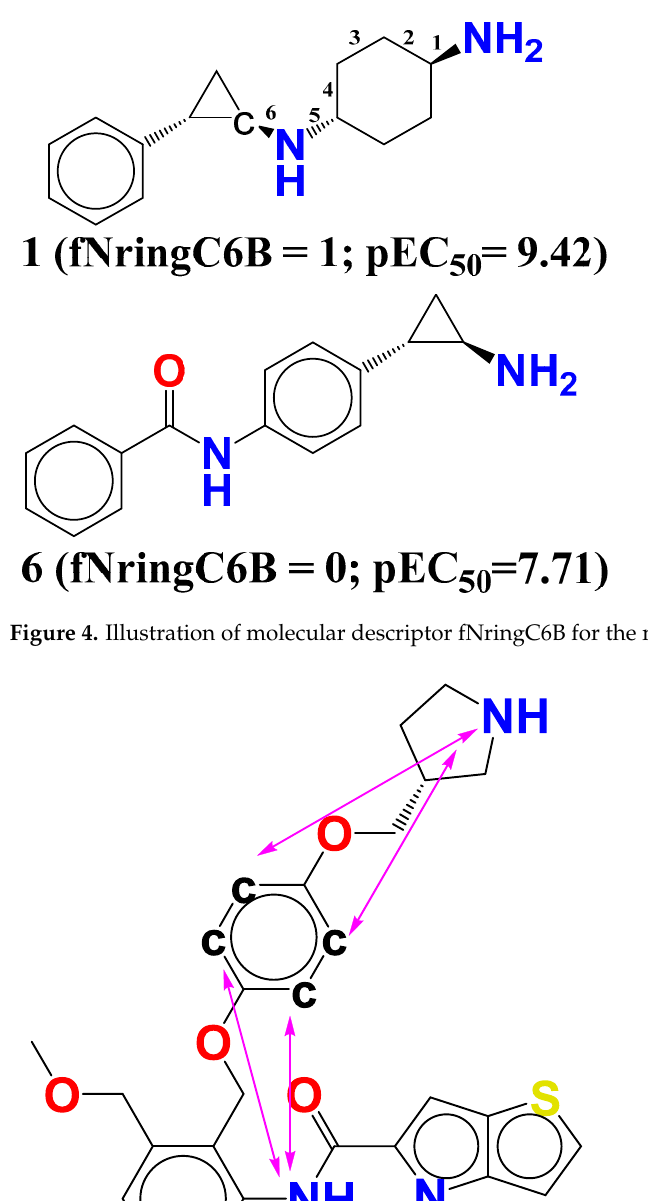
Figure 5. Depiction of the molecular descriptor fNringC6B in the compound 2